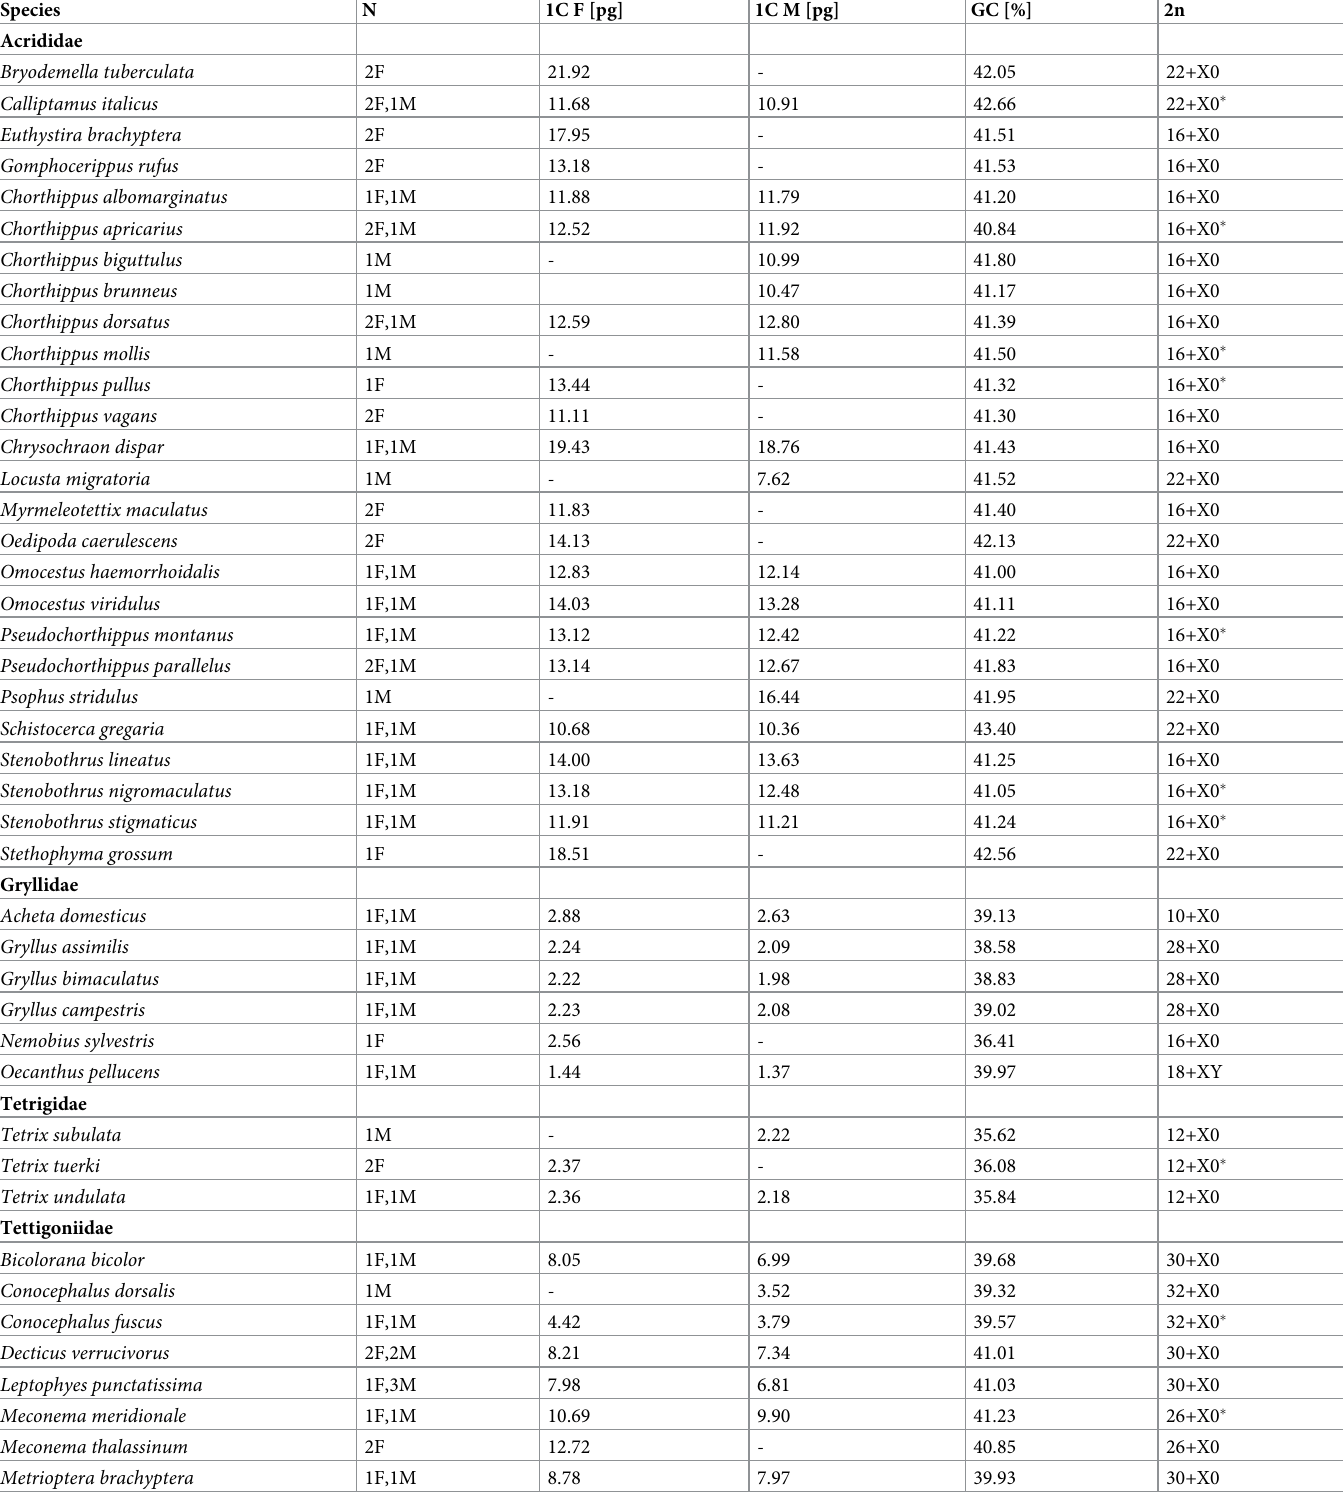
Table 1. A list of genomic and cytogenetical data on all 50 species measured for this study.